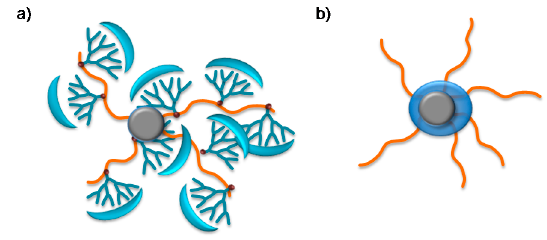
Figure 12. ( a ) Dendronized umbrella effect; ( b ) Core-brush effect.